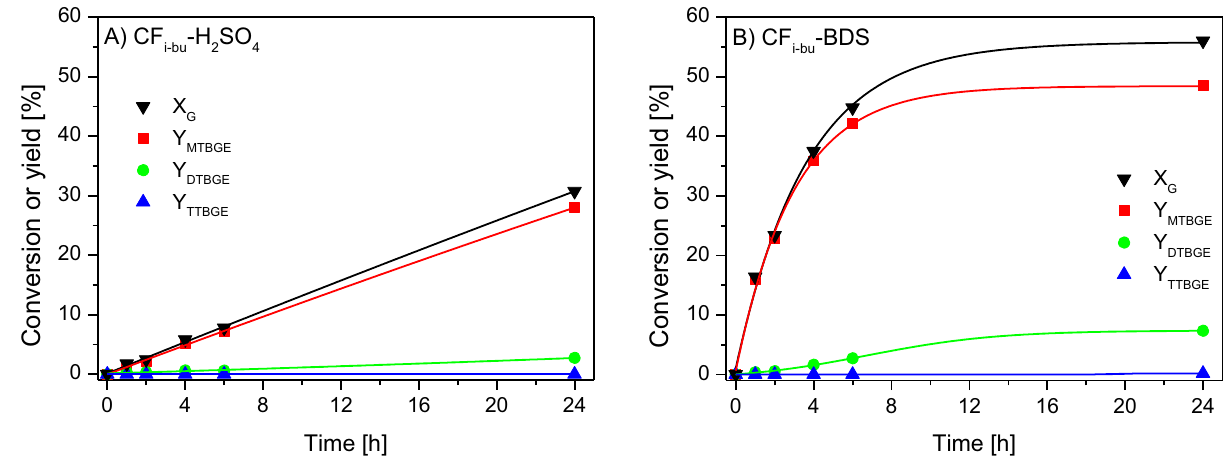
Figure 7. Conversions of glycerol (X G ) and yields (Y) of individual products obtained in the glycerol etherification performed with tert-butyl alcohol over ( A ) CF i-bu -H 2 SO 4 , ( B ) CF i-bu